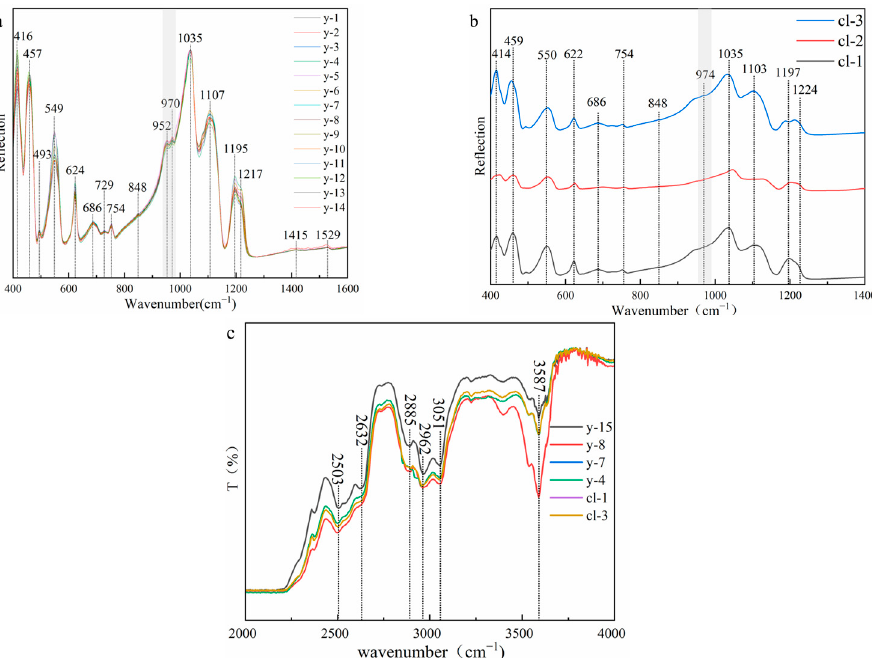
Figure 6. ( a ) Infrared spectra (reflection) of yellow samples; ( b ) infrared spectra (reflection) of colorless samples; ( c ) infrared spectra (transmission) of scapolites.